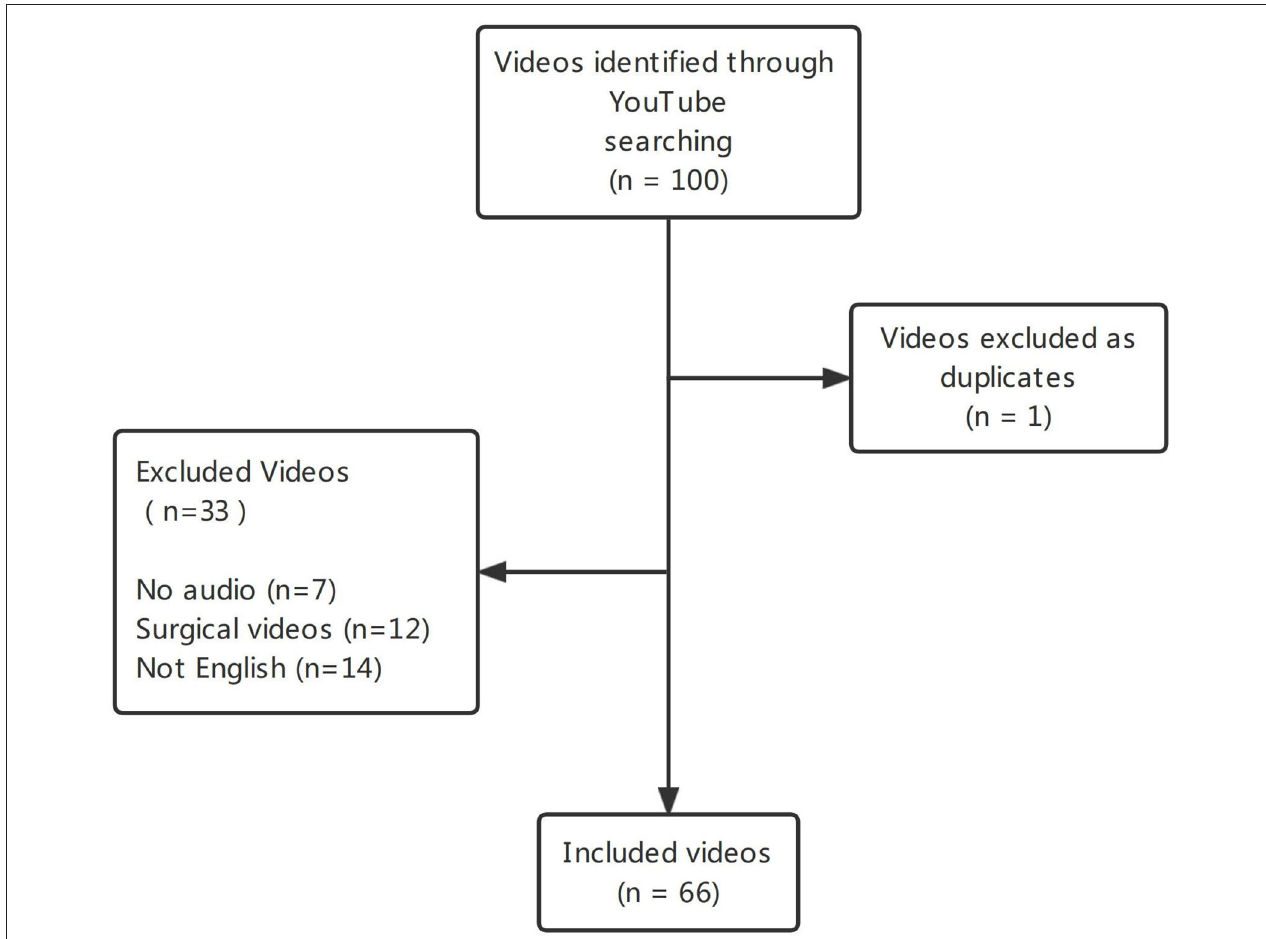
FIGURE 1 | Flowchart of the selection of YouTube videos for